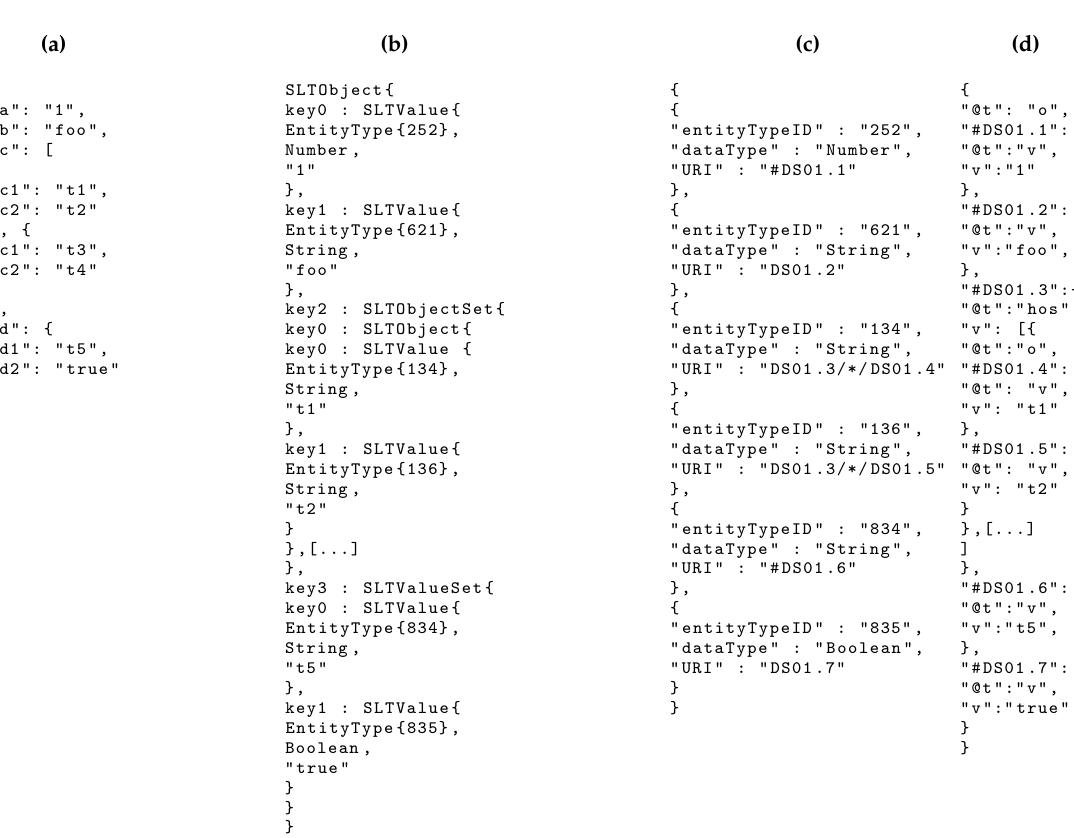
Listing 2. Transformation of a raw JavaScript Object Notation (JSON) data point to the Semantic Linked Tree (SLT) format. (a) Raw JSON data of a single data point of a data set to be integrated into the information storage. (b) Structure of an integrated data point in SLT format. The ’d’ value object has been flattened to single values. (c) Semantic configuration example. Maps Entity Type IDs to instances of SLT node entries identified by the URI member (* indicates a set of children). (d) Resulting integrated SLT. Entity Type and data type are not serialized as they are defined by the Semantic